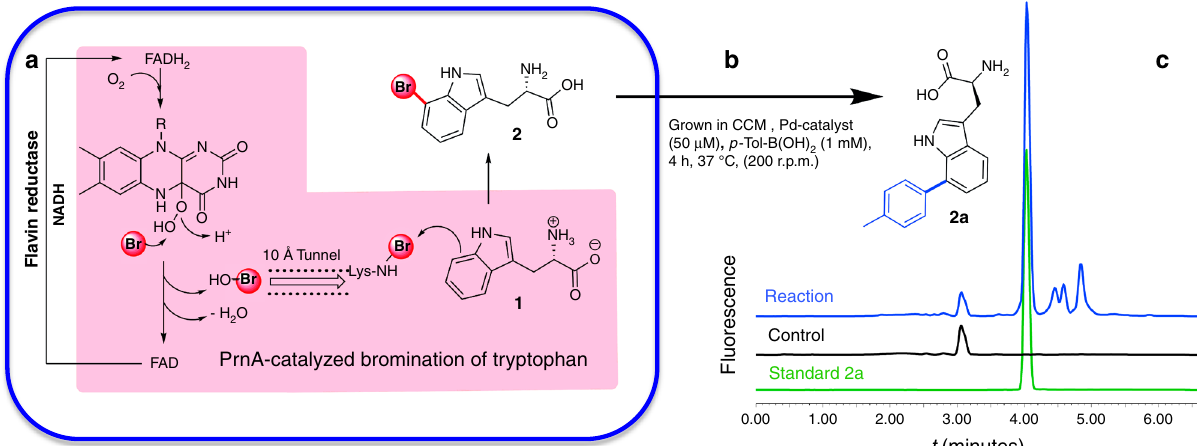
Fig. 5 Synchronous production and cross-coupling of 7-Br-trytpophan. a E. coli PHL644 engineered to produce tryptophan 7-halogenase (prnA) ( E. coli RG- 1500). b Cross-coupling of the 7-Br-tryptophan 2 produced in living culture. An approximate conversion of 61% can be calculated based on the levels of the cross-coupled product 2a observed and based on the concentration of 7-Br-tryptophan 2 at the start of cross-coupling; however, as 7-Br-tryptophan 2 can be constantly produced and metabolized by living cultures, this can only be an approximation. c UPLC analysis, fl uorescence chromatograms of the cross- coupling reaction ( top trace ), a control culture without Pd-catalyst or boronic acid ( middle ) and a puri fi ed standard of product 2a ( bottom trace